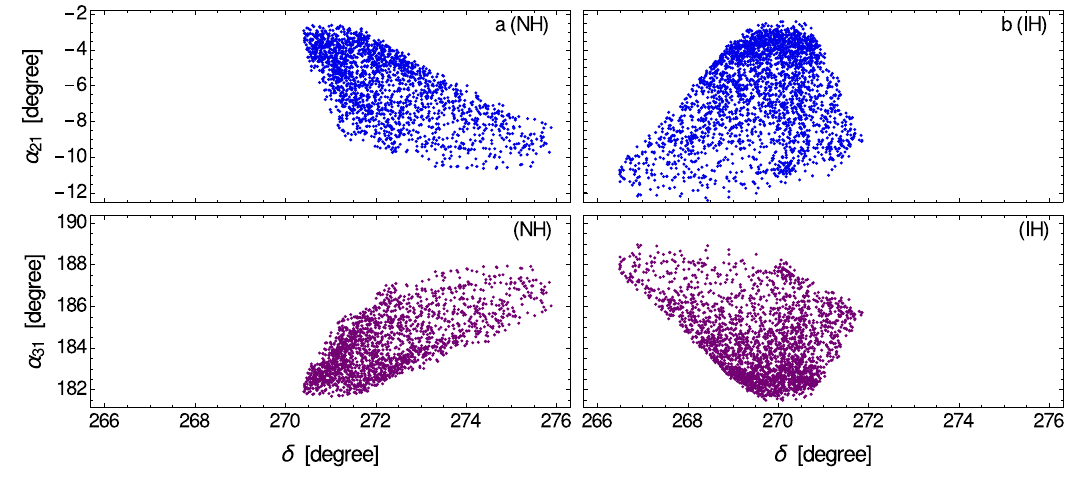
Figure 2 . Scatter plots of the phases δ , α 21 , and α 31 following from the constraints (3.1). Figure 2a is for a normal ordering of the neutrino masses and figure 2b is for an inverted